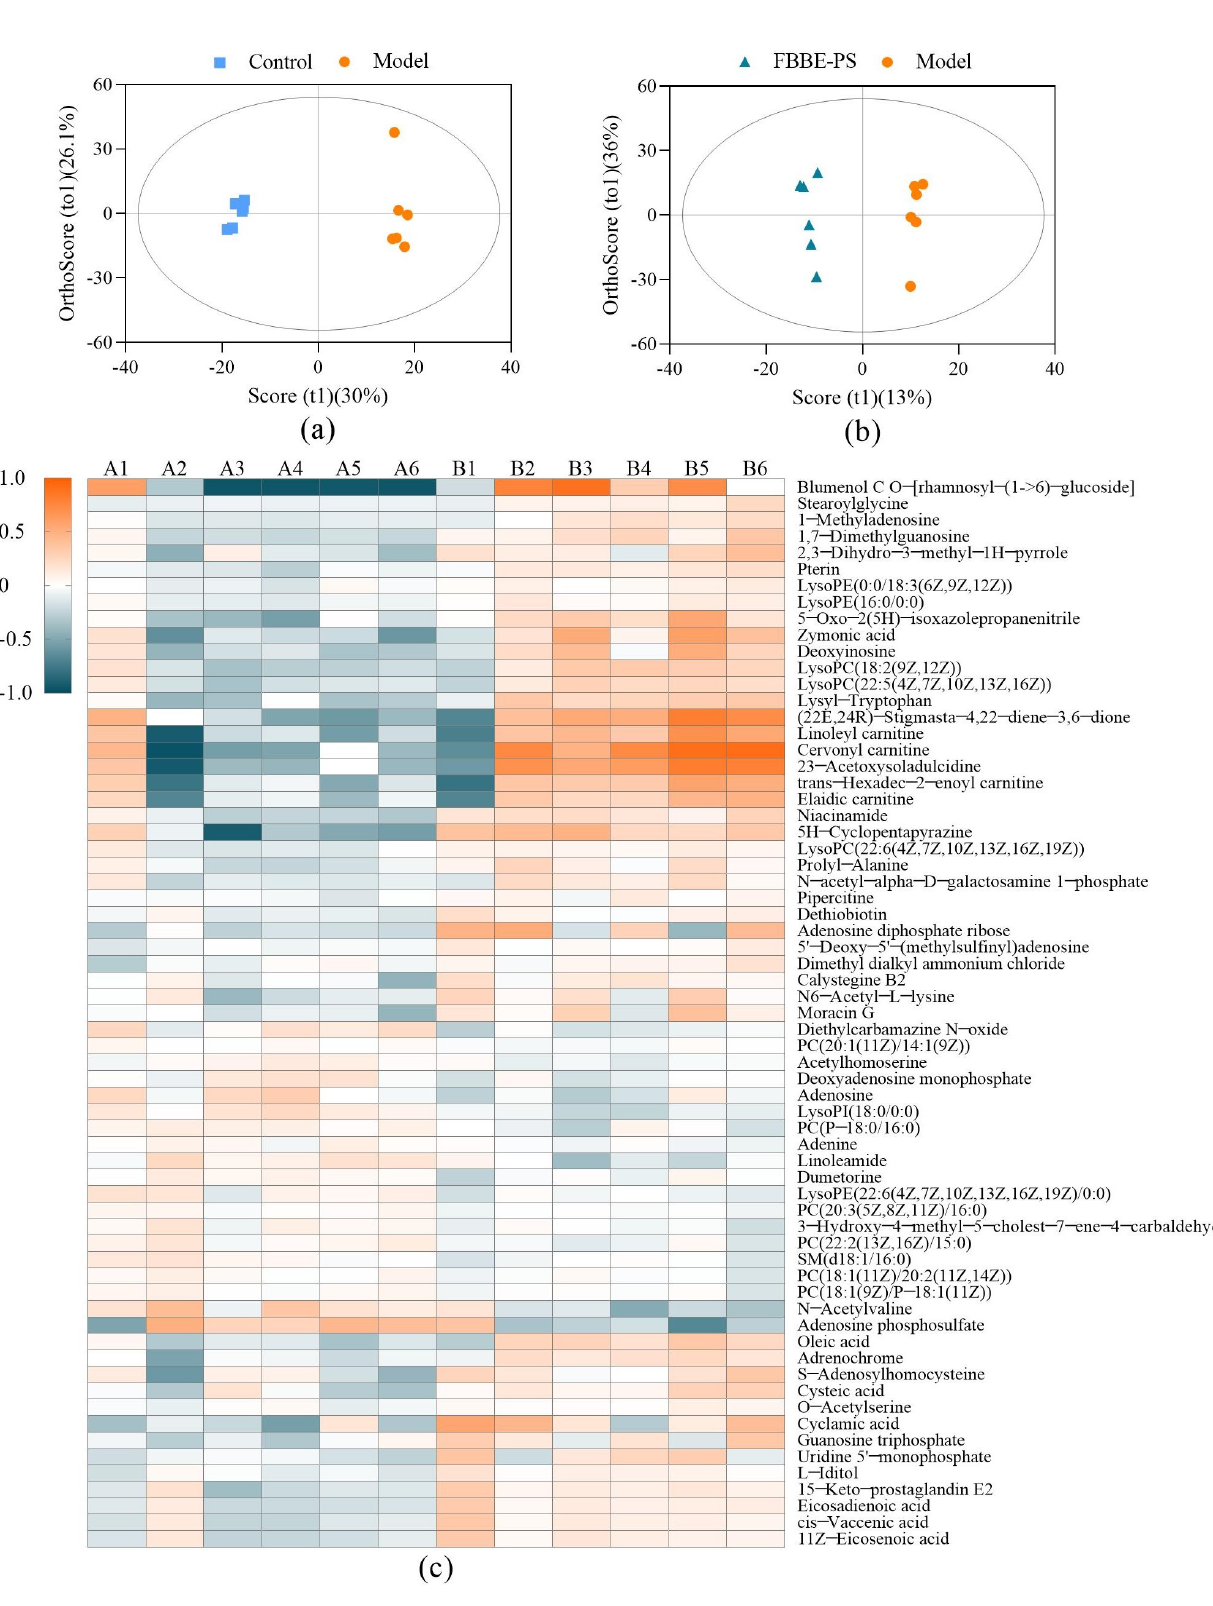
Figure 5. OPLS-DA plots of the control group vs. the model group ( a ) and FBBE-PS group vs. the model group ( b ). Heatmap plot ( c ) of differential metabolites in FBBE-PS group (A) and the model group (B).